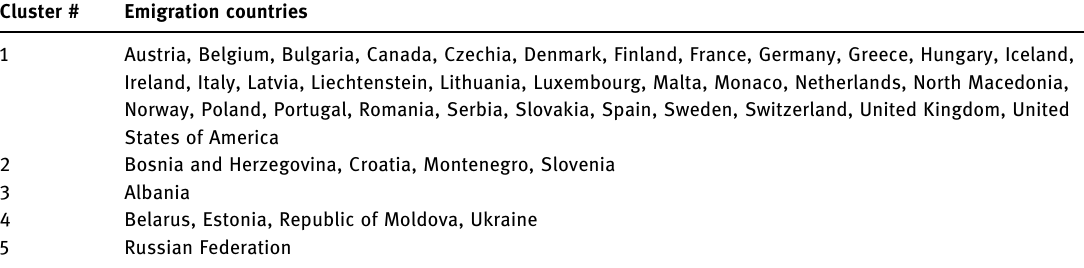
Table 1: Country memberships of emigration trait clusters, 2015 Cluster #